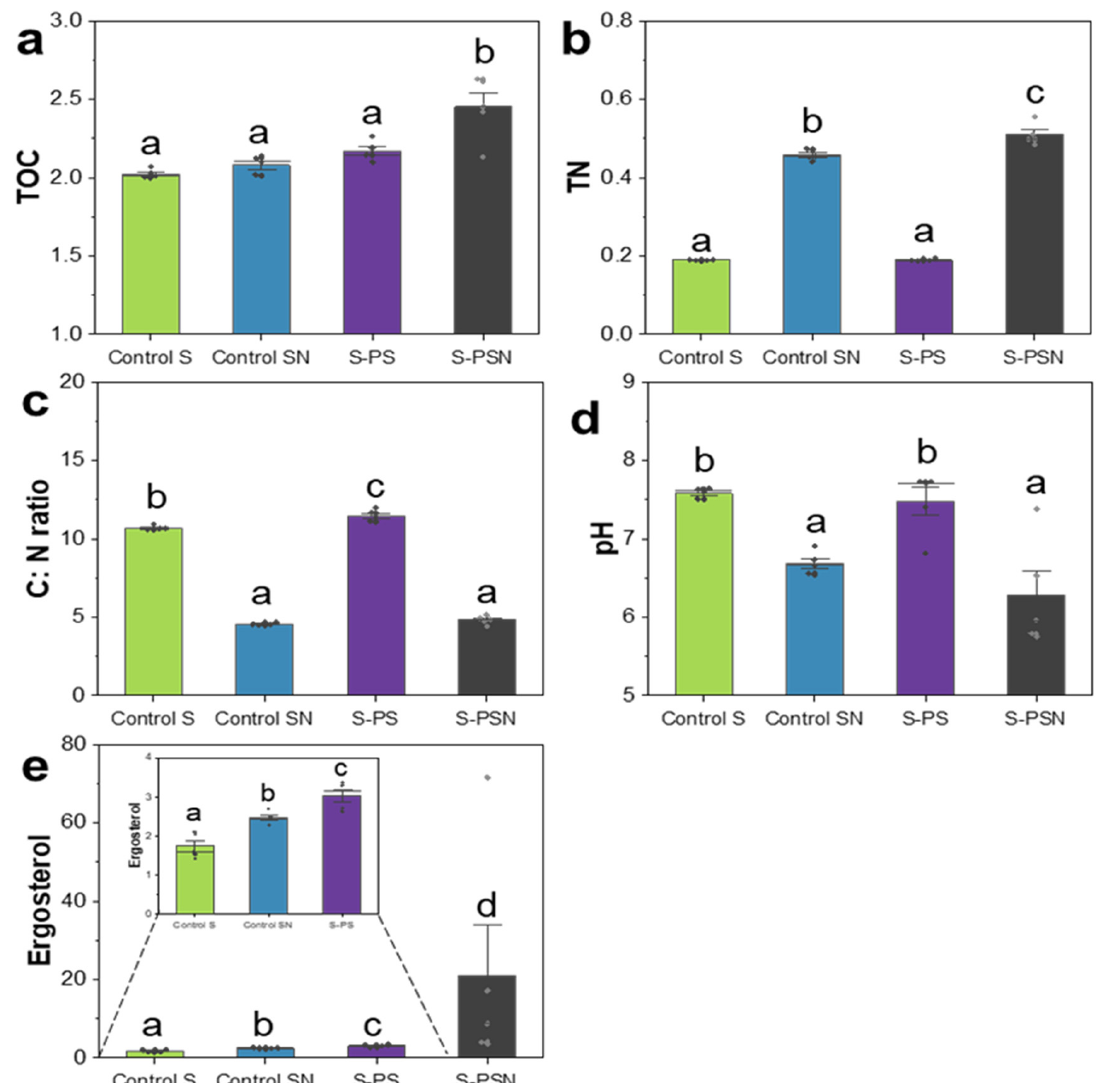
Figure 3. Mean of total organic carbon (TOC, ( a )), total nitrogen (TN, ( b )), C: N ratio ( c ), soil pH ( d ), and ergosterol content ( e ) of each treatment. Analysis of variance (ANOVA) or Kruskal–Wallis test was performed for the data with equality and non-equality of variance, respectively. Standard deviation of five replicate measurements are shown. The rhombs on the bars indicate the data points. Different letters indicate significant differences according to ANOVA ( p < 0.05). Details of the treatment abbreviations can be found in the legend of Figure 1.